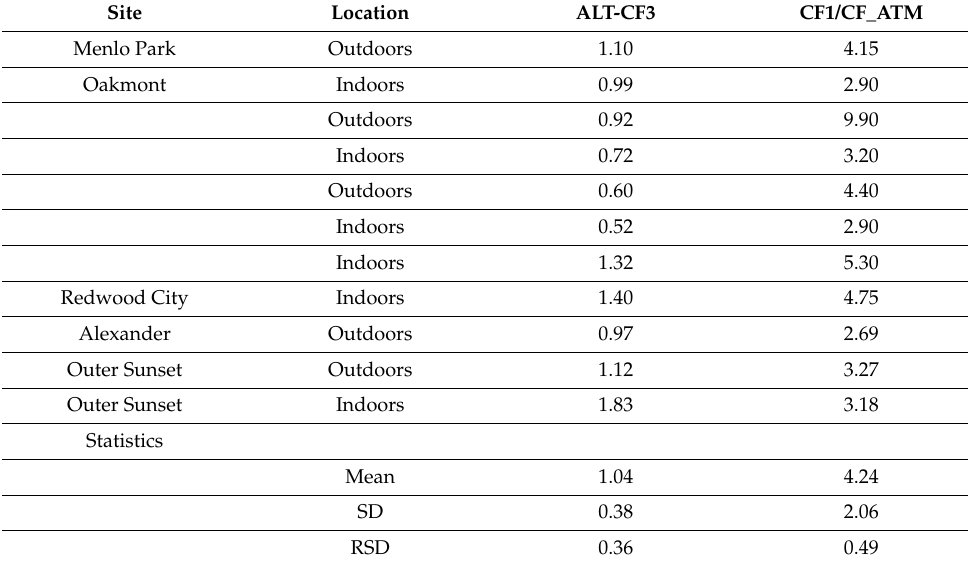
Table 6. Calculations of the LODs ( µ g/m 3 ) for 5 of 6 sites.